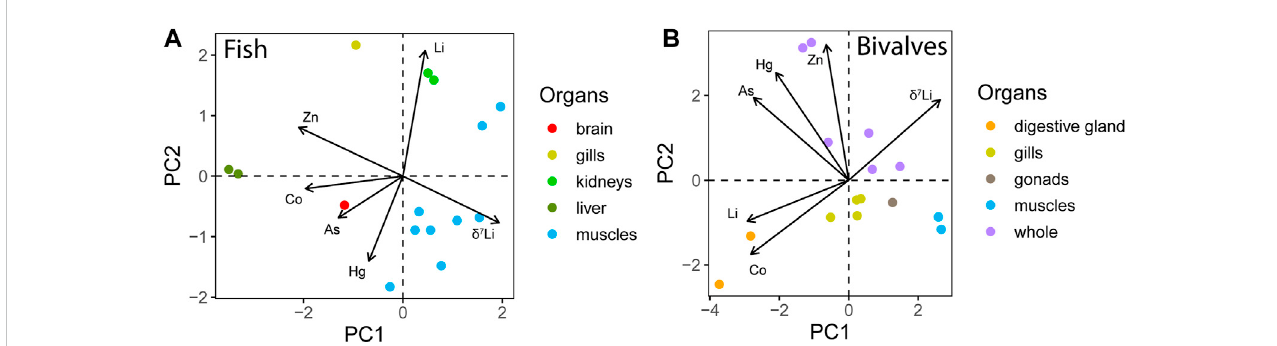
FIGURE 2 Principal component analysis (PCA) of all fi sh (A) and bivalves (B) from the Bay of Biscay. PC1 and PC2 are principal components 1 and 2. Arrow length is proportional to the percentage contribution of these variables to the fi rst two principal components. PC1 and PC2 together represent (A) 67% and (B) 87% of thedatasetvariabilityfor fi sh (A) andbivalves (B) .VariablescanbesplitintotwogroupsforBivalves(As,Hg,andZnvs.Co,Li,and δ 7 Li),whereastheseparationis not straightforward for fi sh. Note that the correlation between Co and Li is exhibited in the Supplementary Figure